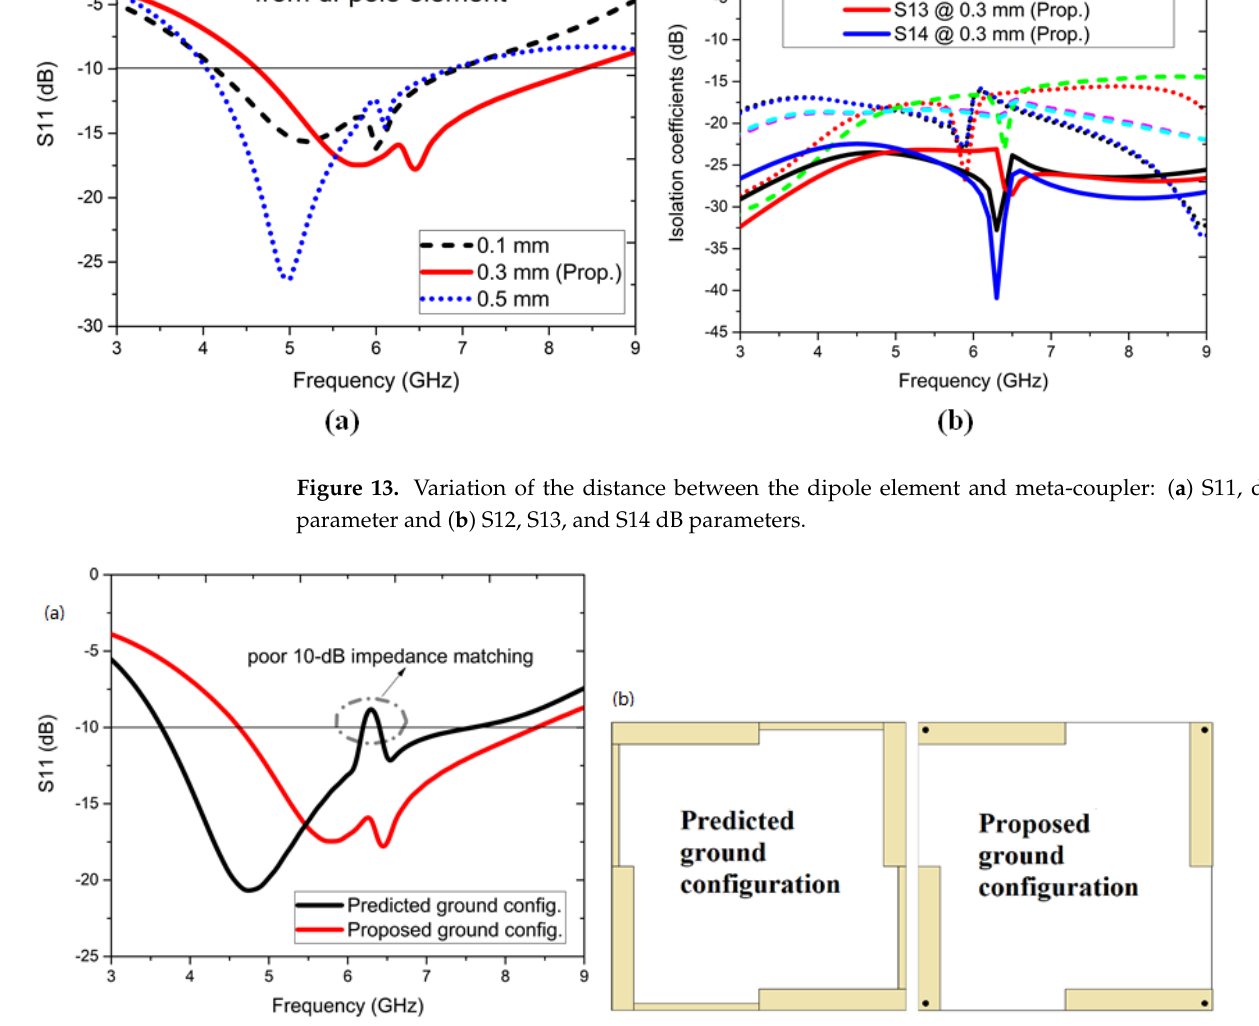
Figure 14. Variation of the ground: ( a ) predicted ground configuration and ( b ) proposed ground